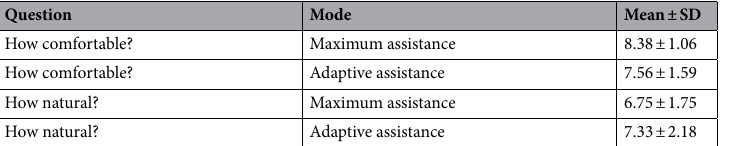
Table 4. Likert scale results. Likert scale where 1 = very uncomfortable and 10 = very comfortable or 1 = not natural at all and 10 = very